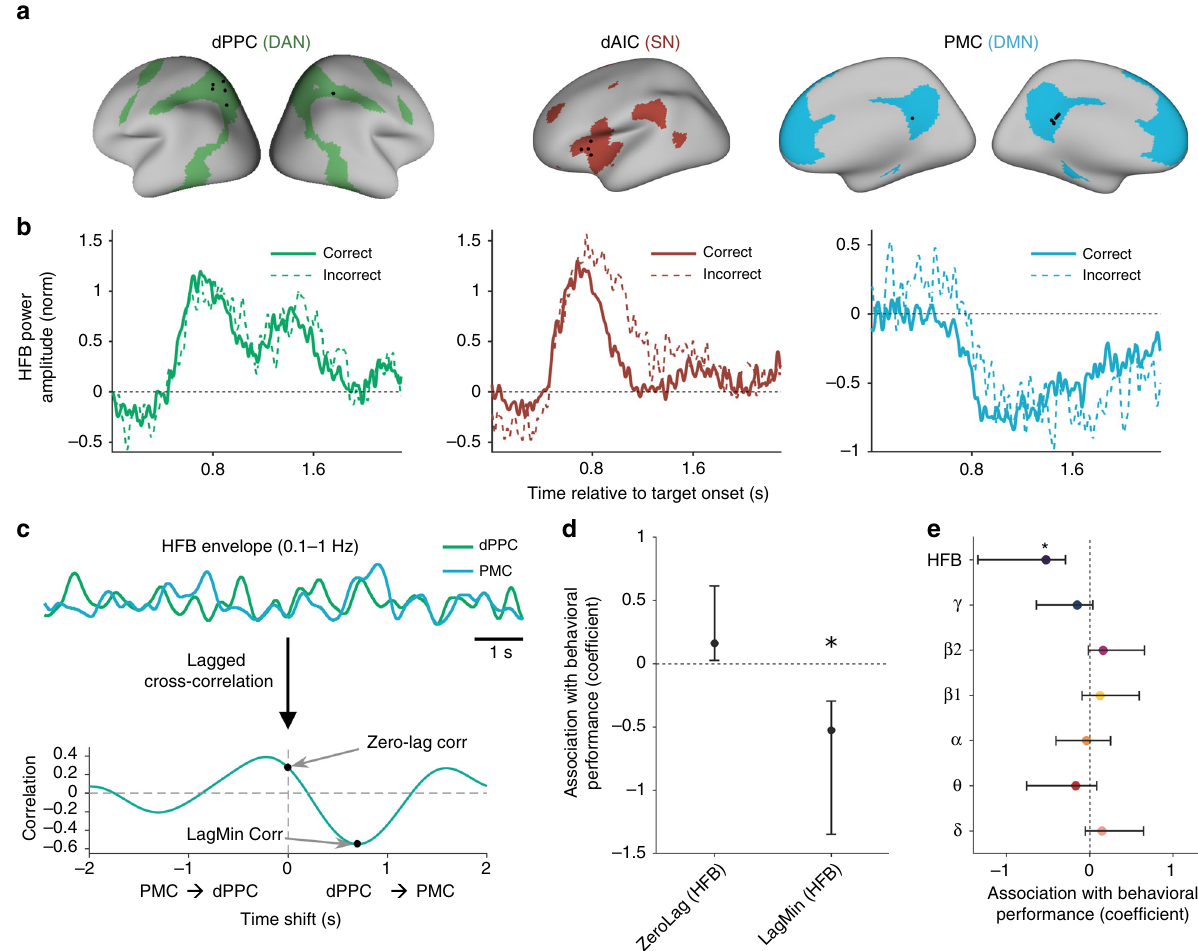
Fig. 5 Relationship between behavioral performance and inter-electrode coupling of key DAN, SN, and DMN nodes. a Locations of peak-responsive dPPC, dAIC, and PMC electrodes (in fsaverage space) within cohorts of subjects with simultaneous dPPC-PMC ( n = 6) and dAIC-PMC ( n = 4) coverage. b Grand average HFB responses during GradCPT correct omission and commission error trials for the electrodes shown in a ) (cf. Fig. 4a). c Illustration of how inter-electrode coupling was calculated from continuous HFB 0.1 – 1 Hz fi ltered time series. Using an example 20-sec time series for illustration purposes (top), a lagged cross-correlation was performed (shifting dPPC relative to PMC and vice versa). (Bottom) The zero-lag correlation was taken as the value with no time shift, whereas the lag-minimum correlation was taken as the minimum value across the time shifts. In the main analysis, these metrics were calculated based on whole runs (typically 6 min long). d Coef fi cients from a linear mixed model with d ′ (behavioral performance) as dependent variable and with fi xed factors including lag-minimum and zero-lag 0.1 – 1 Hz HFB correlation between dPPC and PMC (and including subject modeled as random factor). e Coef fi cients as in d for lag-minimum correlations in separate linear mixed effects models that were each constructed from power amplitudes of distinct frequency bands. Error bars indicate upper and lower 95% con fi dence intervals. Asterisks indicate signi fi cant effects ( p <0.05, Satterthwaite ’ s approximation, F test on linear mixed effects